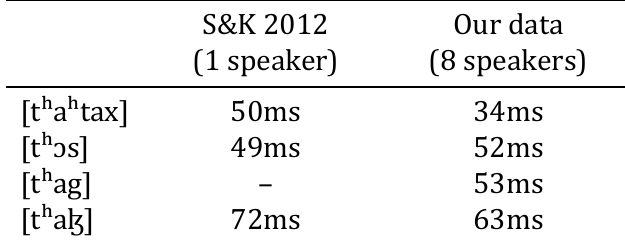
Table 7: Comparison between previous reports and our results: C₁ release duration in different